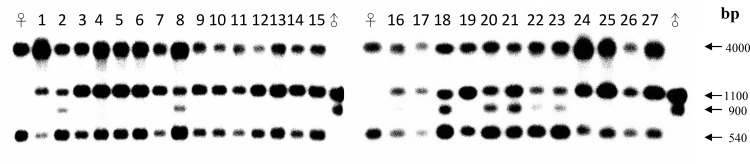
Southern blot analysis of the external transcribed spacer (ETS) patterns for each sample using total genomic DNA that was cut with the XbaI and DraI restriction enzymes.Lanes ♀ and ♂ represent the maternal parent (Ascocenda John De Biase ‘Blue’) and the paternal parent (Phalaenopsis Chih Shang's Stripes), respectively. Lanes 1–27 represent the putative F1 hybrids.